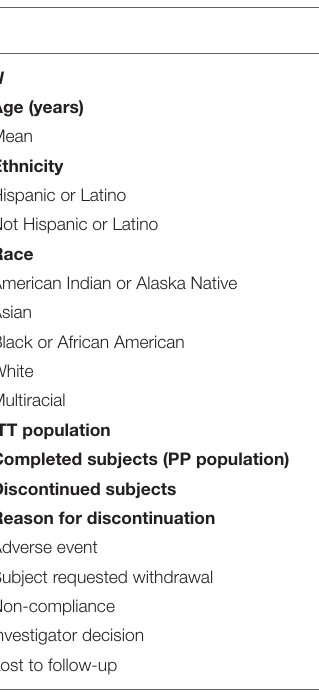
TABLE 4 | Demographic information on clinical trial #3.